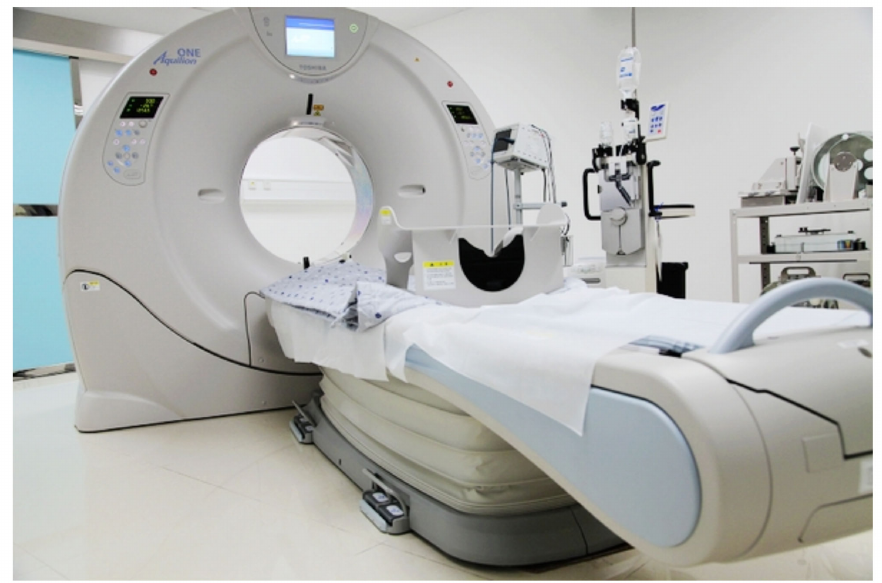
Figure 1. Toshiba Aquilion ONE 640-slice dynamic organ volume CT (taken in the Radiology Department, the Sixth Affiliated Hospital of Sun Yat-sen University).